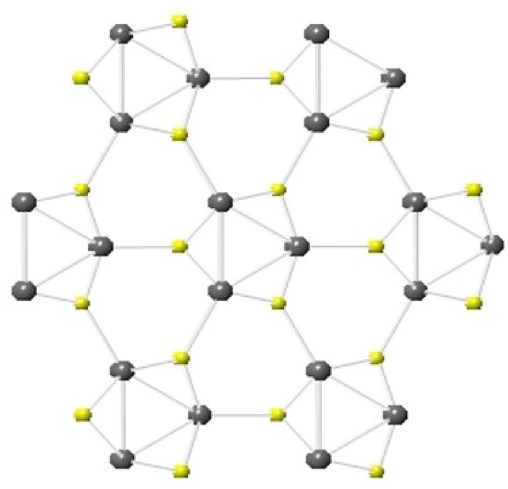
Figure 9. Crystal structure of NiS millerite phase viewed along [001] plane. The image was drawn by using the licensed CrystalMaker software (version 9.2.9f1 (665)) (http://crystalmaker.com/).